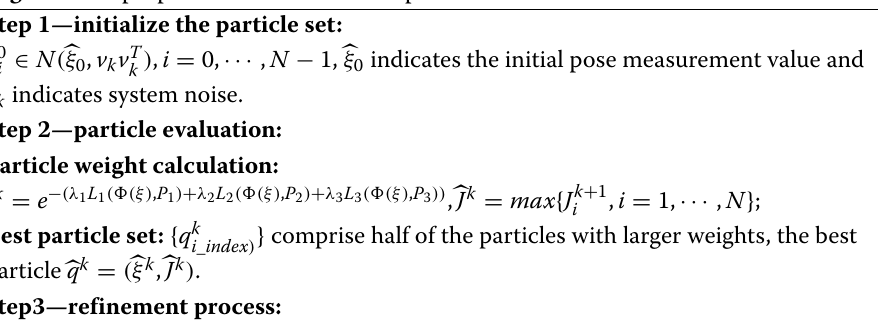
Algorithm 1 proposed method for circle pose